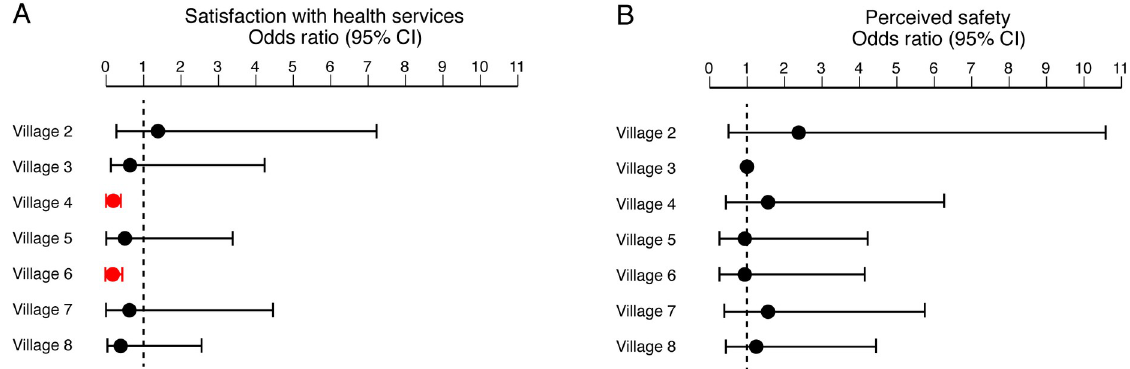
Fig 6. Features of health seeking behavior by respondents in different villages. Odds ratios are based off a reference to Village 1. Panel A: Satisfaction with health services. Panel B: Perceived safety of health facility. Red symbols: p < .001.